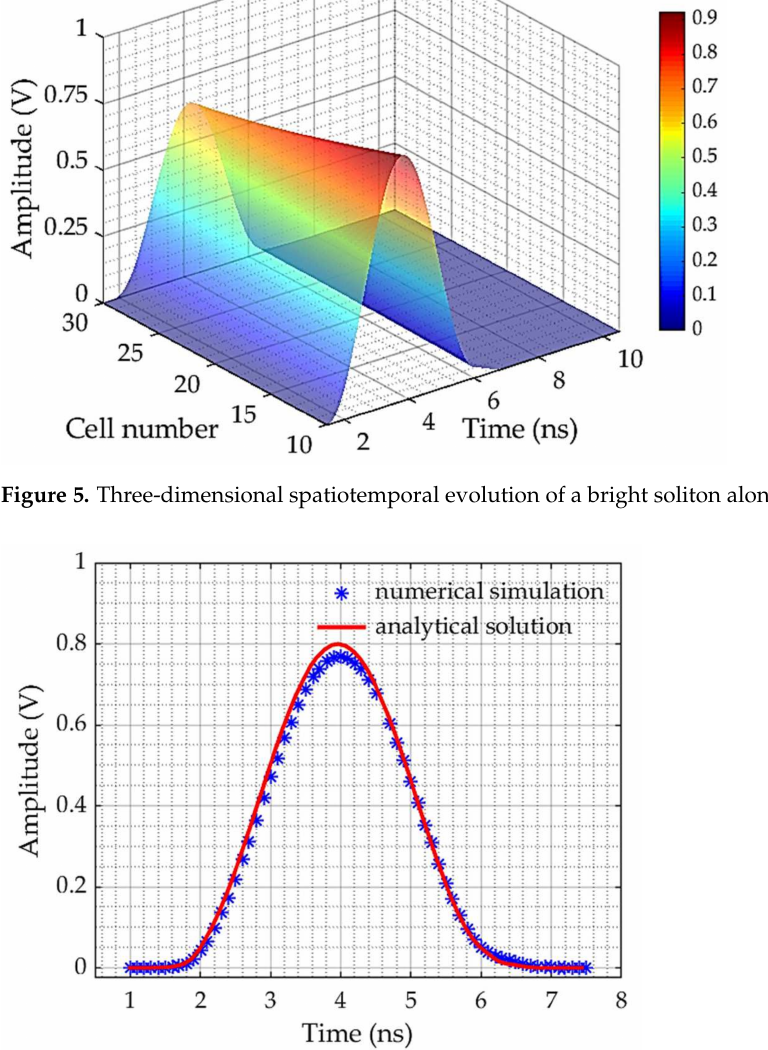
Figure 6. Analytical and numerical soliton waveforms at 20th cell of the lossy